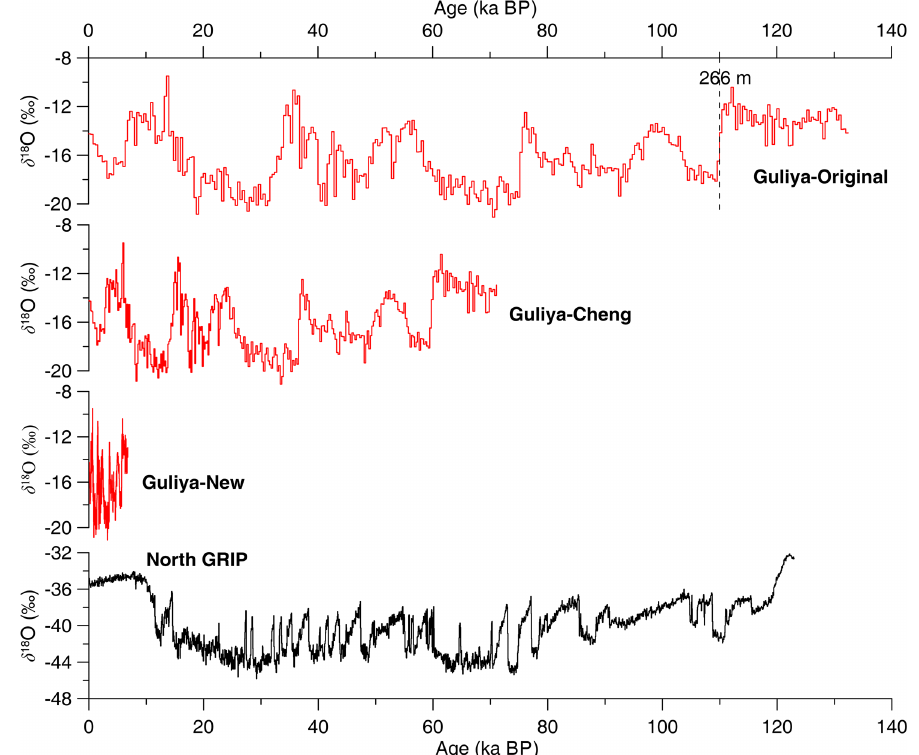
Figure 4. The δ 18 O profiles of the Guliya and North Greenland Ice Core Project (GRIP) ice cores. The Guliya-Original profile is plotted on its original chronology (Thompson et al., 1997). The Guliya-Cheng profile is the original Guliya record linearly compressed by a factor of 2, as suggested in Cheng et al. (2012). The Guliya-New profile is the original Guliya record further compressed linearly so that the high δ 18 O values fall within the warm Holocene.